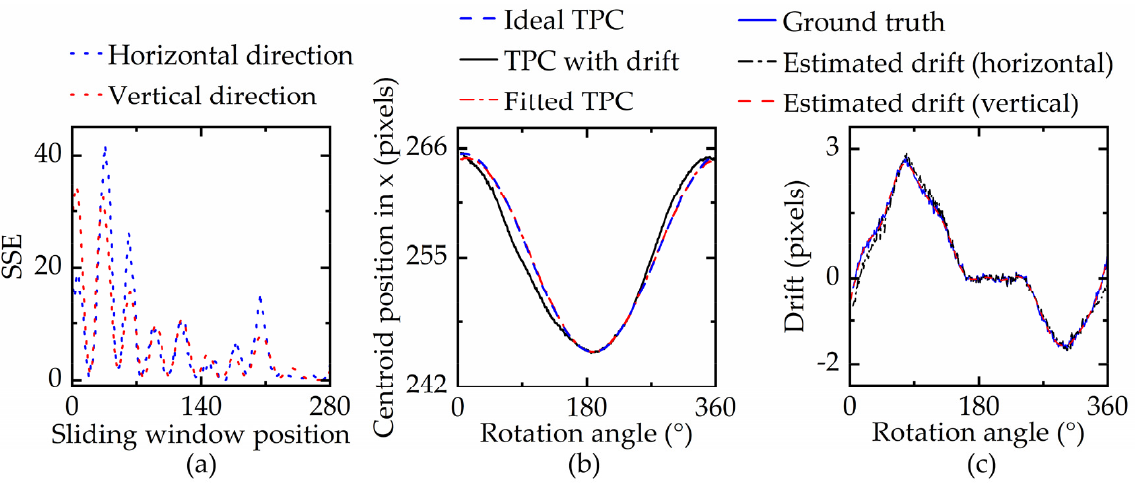
Figure 5. The drift correction process. ( a ) The process to find the stable projection interval based on the minimization of SSE between the fitted TPC and measured TPC; ( b ) H-TPC; ( c ) the estimated projection drifts.